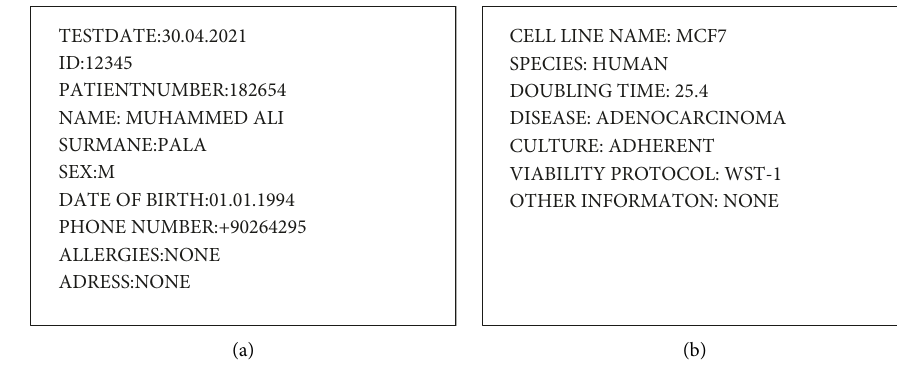
Figure 12: Watermark texts (a) for cancer cell image and (b) blood image.